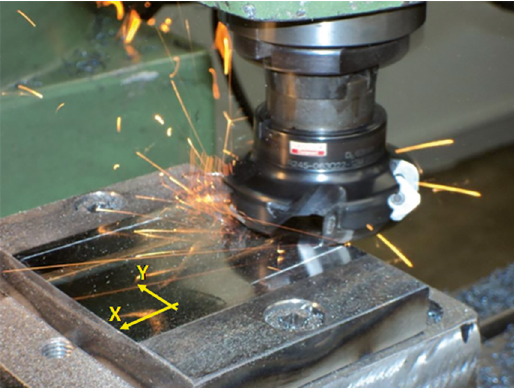
Figure 3. Pareto diagram of the influence of cutting parameters in the